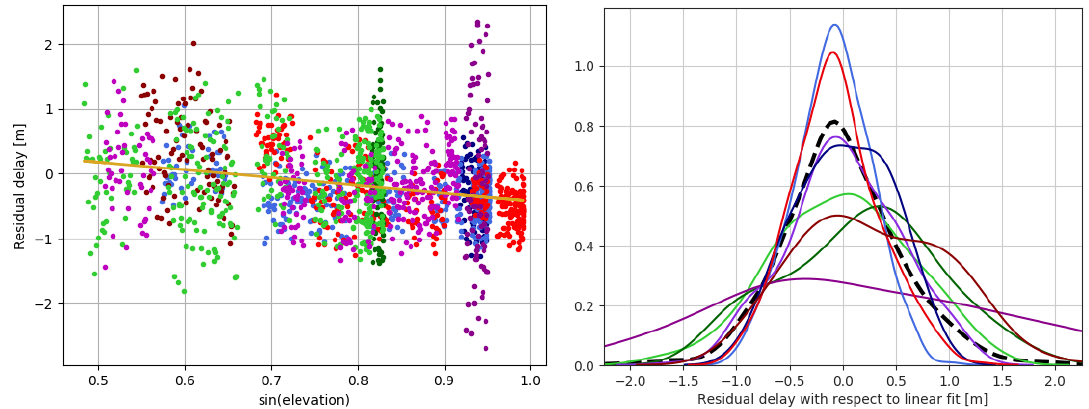
Figure 7. ( Left ) Evolution ∆ ρ as a function of sin ( ε ) . The different color stands for different PRN: GPS PRN01 in blue, GPS PRN03 in red, Galileo PRN11 in green and Galileo PRN19 in magenta. A darker tone refers to L5 results. ( Right ) Estimated probability density function of ∆ ρ with respect to the linear fit for the different GNSS signals (same color-code) and for their combination (black dashed line).